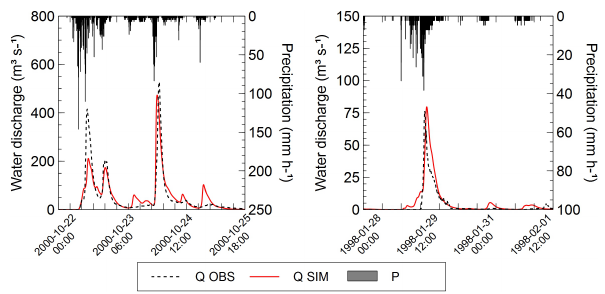
Fig. 7. Hydrological calibration (left) and one of the temporal vali- dations (right) at 5min time resolution.